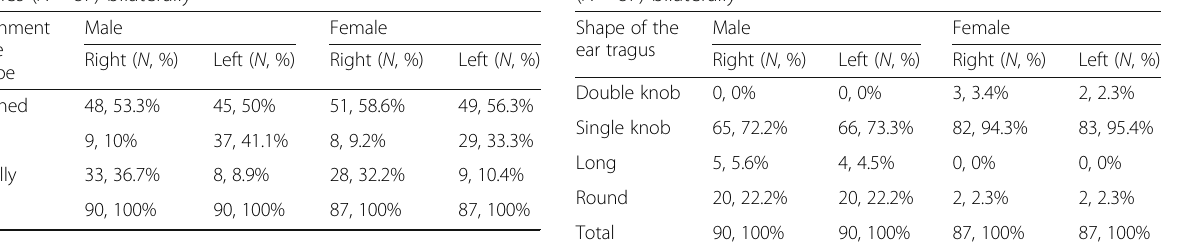
Table 6 Shape of the ear tragus in males ( N = 90) and females